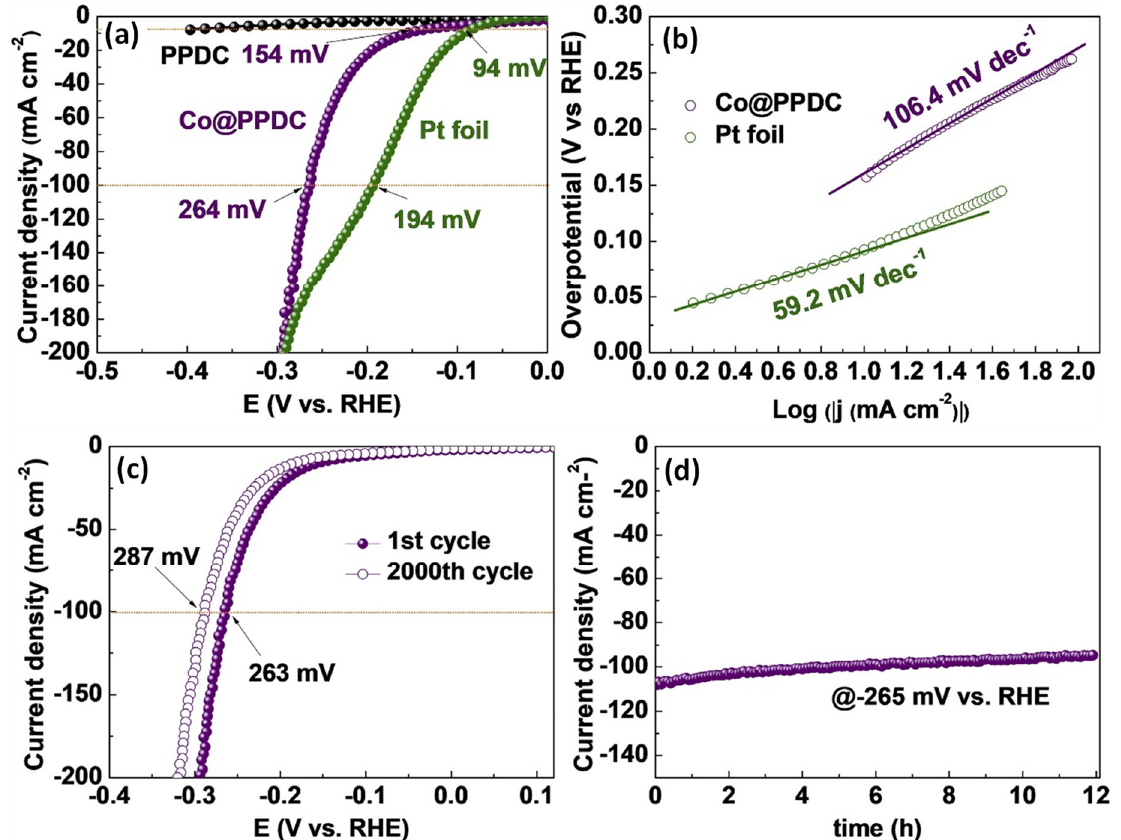
Figure 13. ( a ) LSV curves (1.0 M KOH, scan rate = 0.5 mV s −1 ); ( b ) Tafel plots for a pomelo peel-derived porous carbon membrane embedded with Co NPs (Co@PPDC) and Pt foil; ( c ) LSV curves of Co@PPDC during the 1st and 2000th catalytic cycles; and ( d ) long-term stability tests of Co@PPDC at an overpotential of 265 mV in 1.0 M KOH electrolyte. Adapted from [198], Copyright (2020), with permission from Elsevier.